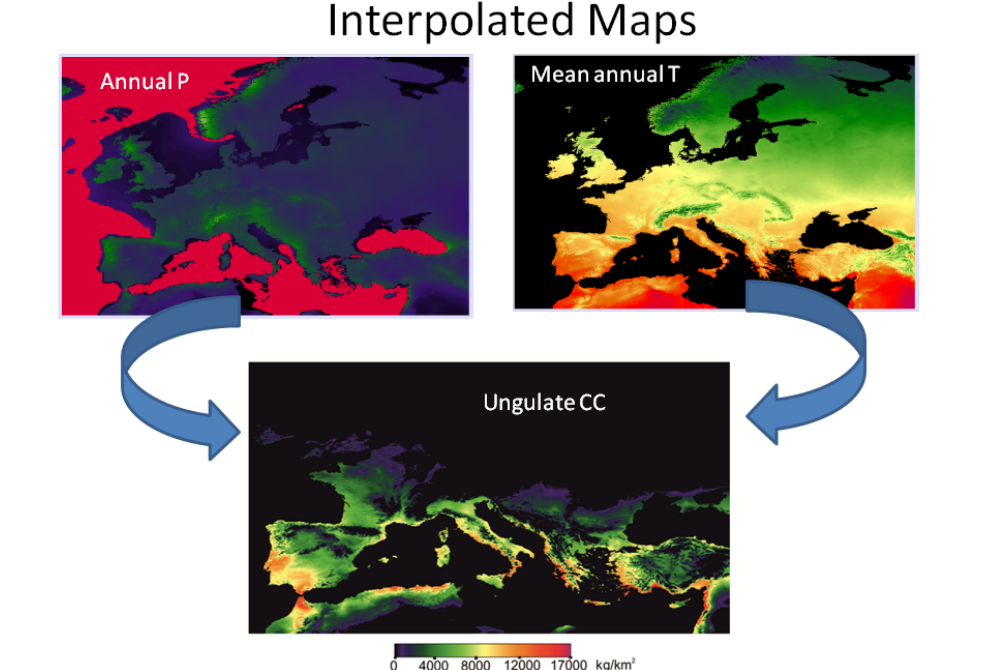
Figure 10. Example of the estimation of ungulate carrying capacity (Ungulate CC) in southern Europe for the period 1.6–1.07 Ma. from interpolated maps of annual rainfall (Annual P) and mean anual